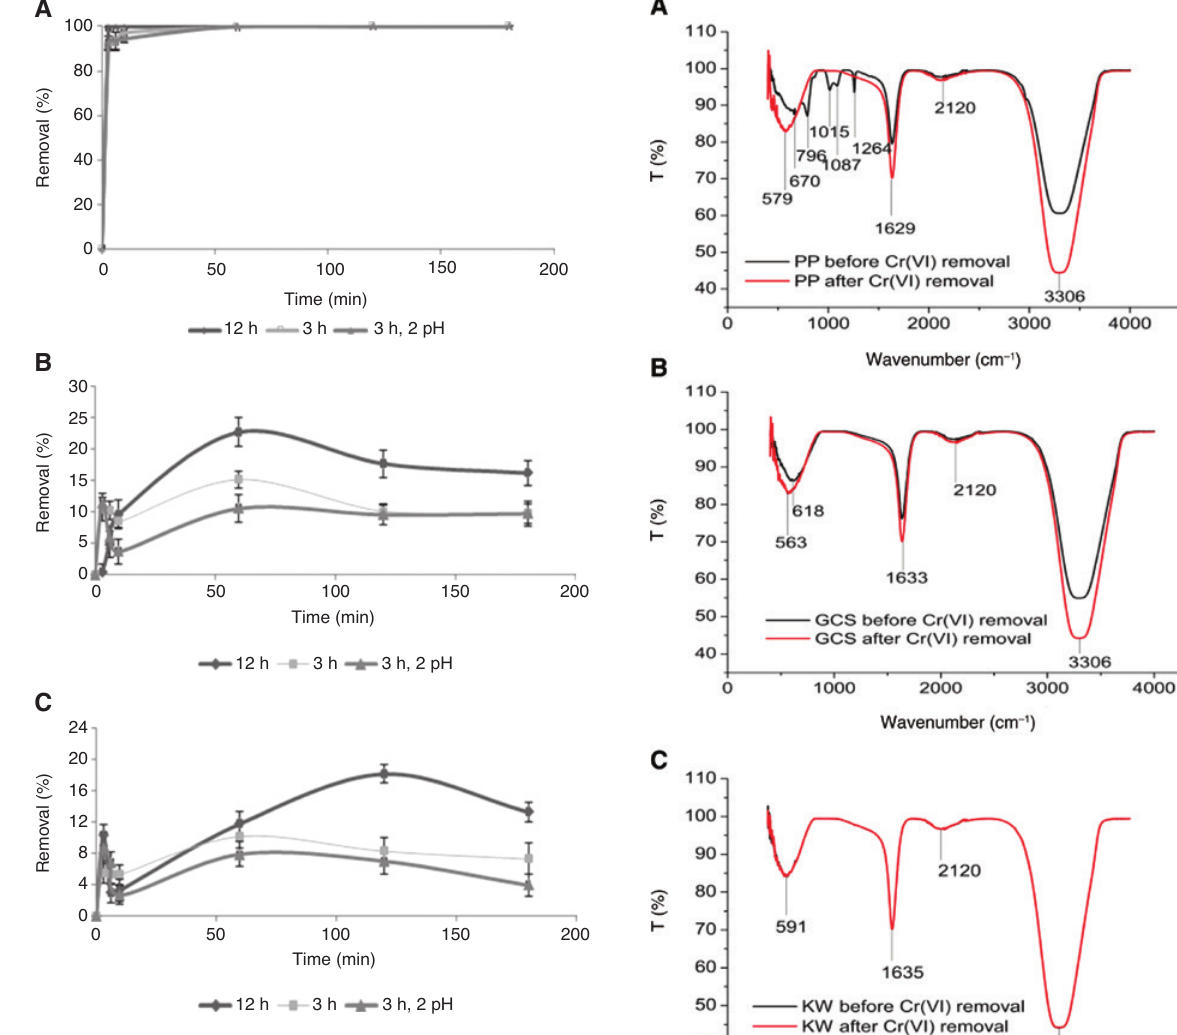
Figure 5: Percentage removal of Cr(VI) using (A) PP, (B) GCS, and (C) KW extracts at 303 K and pH 2.